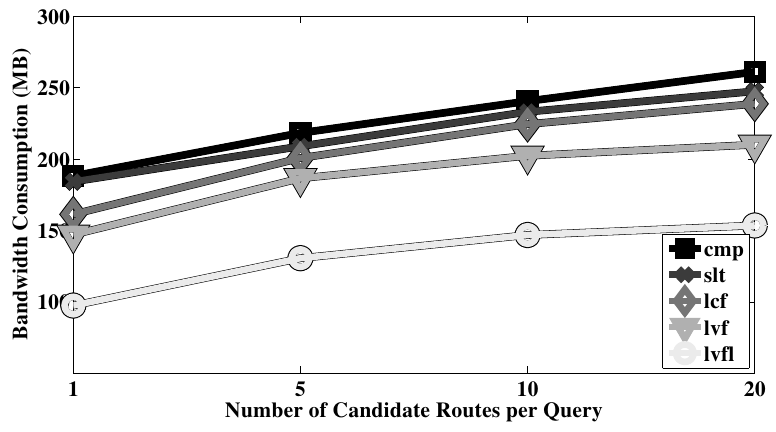
Figure 7. Varying number of candidate routes per